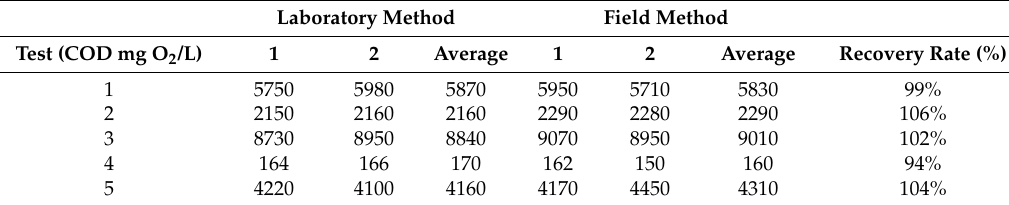
Table A6. COD measurement raw data.